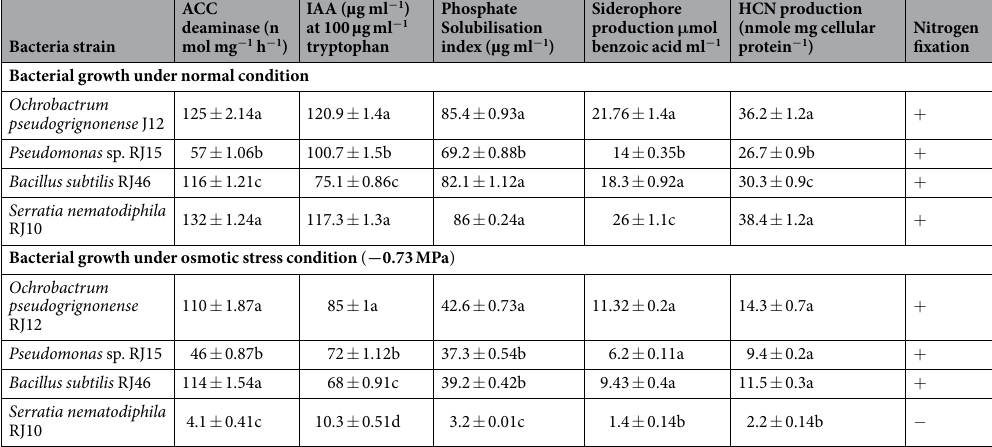
Table 1. Plant growth promoting traits of bacterial strains, Ochrobactrum pseudogrignonense RJ12, Pseudomonas sp RJ15 and Bacillus subtilis RJ46 under normal and osmotic stress condition ( − 0.73 MPa). An osmotic stress sensitive PGP strain Serratia nematodiphila RJ10 was taken for comparison throughout the experiment. One-way ANOVA was performed in both the table considering the activity of Serratia nematodiphila strain RJ10 as independent variable, followed by Tukey’s test. Means within a column sharing same lowercase letter are not significantly different at p = 0.05; figures are means ± standard deviation (n = 5). Table key: “ + ” positive for the test; “ − ” negative for the